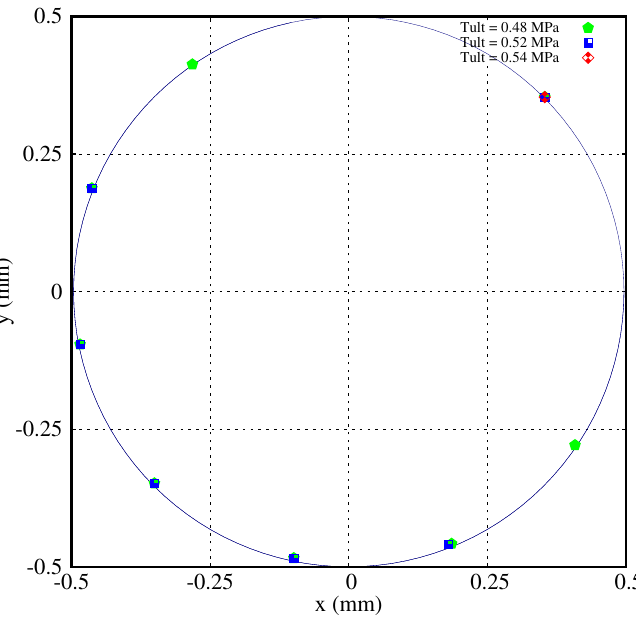
Figure 5. Crack nucleations with different ultimate strengths of the shell. Every coloured dot represents one nucleation site. The results of three separate computations with different values of the shell’s ultimate strength are superimposed. The colour of the dot specifies the computation to which it